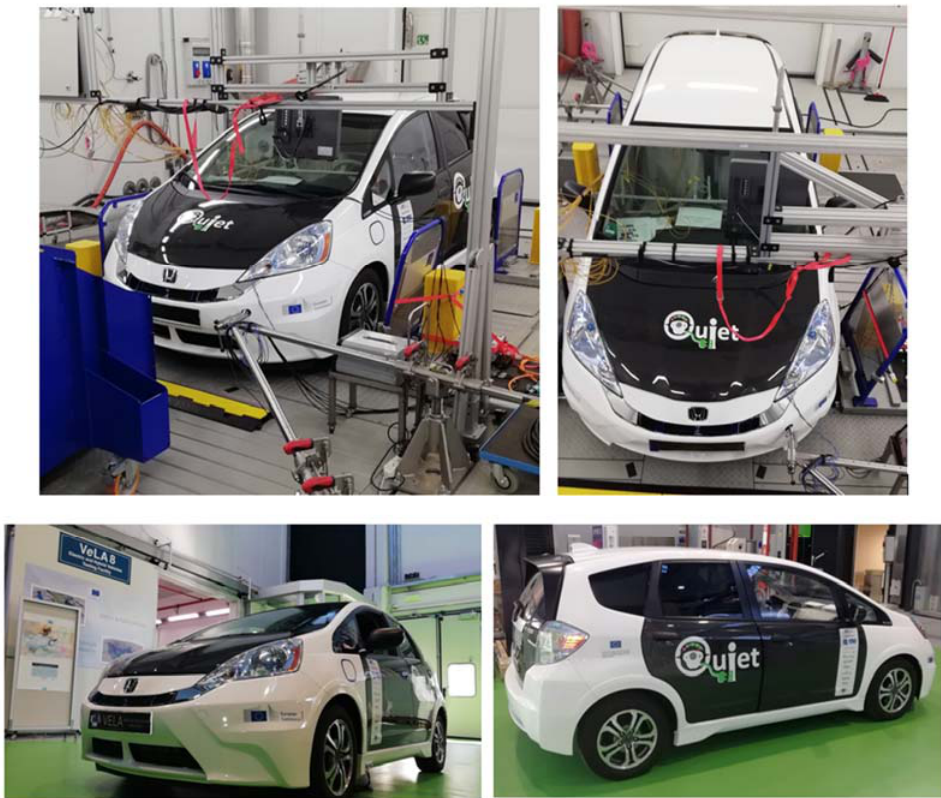
Figure 3. QUIET demonstrator tested at the JRC Ispra VeLA 8 facility [18,23,24]. Image © European Union, 2021.